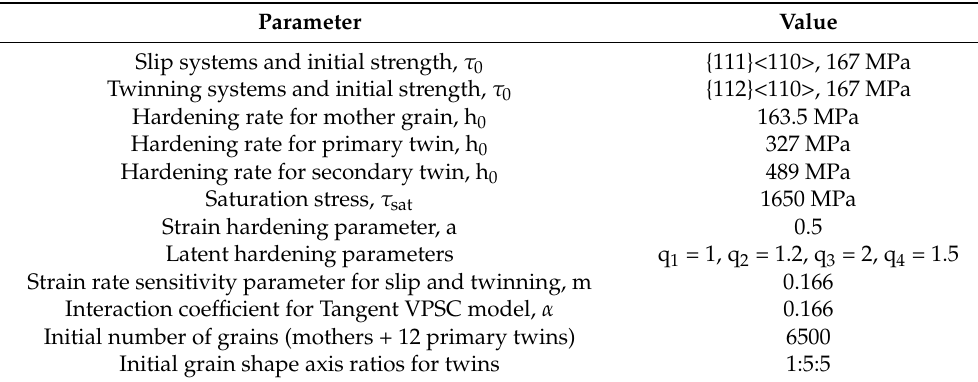
Table 5. List of the polycrystal modeling parameters